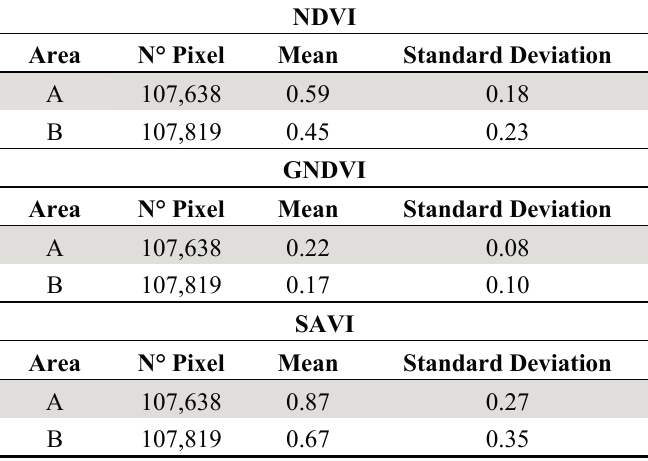
Table 7. Mean and standard deviation of the sample areas A and B in the tomato